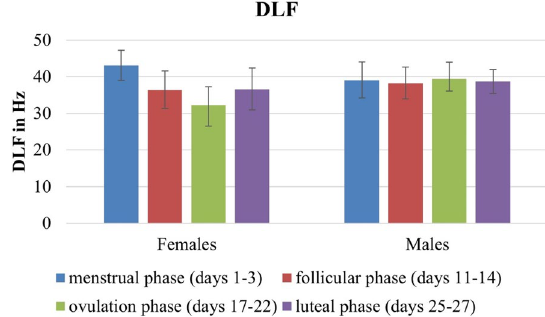
Fig. 2 The mean and standard deviation of scores obtained for DLF in males and females